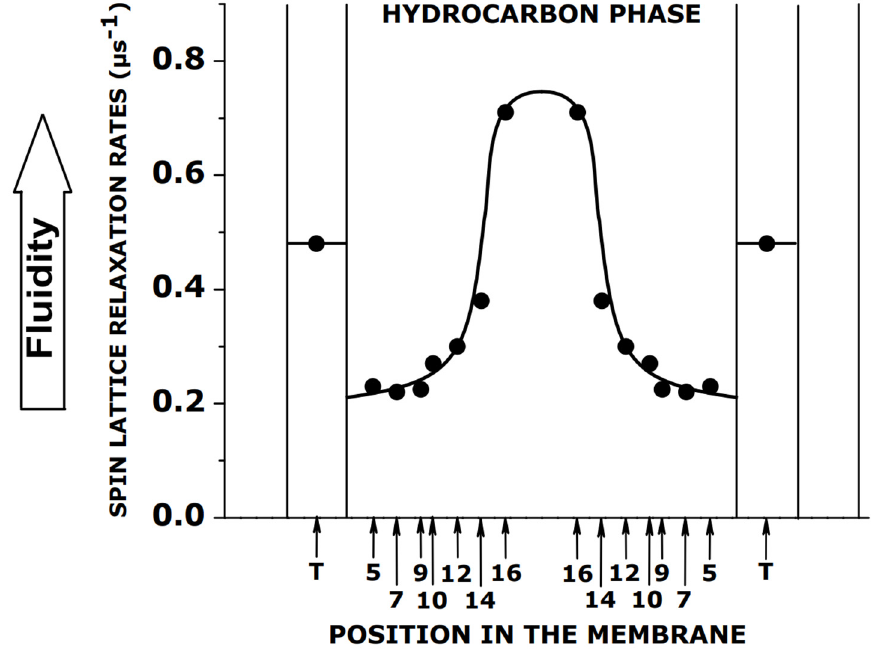
Figure 5. Profile of spin lattice relaxation rates ( T 1 − 1 s) across membranes of multilamellar liposomes made of the lipid extracts pulled from cortical eye lenses of 61–70-year-old human donors. Meas- urements were performed at 37 °C for deoxygenated samples. Locations of spin labels for n-PCs are indicated by numbers and for T-PC by “T”. Based on the data obtained from the neutron diffraction studies on phosphatidylcholine model membranes [64,65] it is assumed that the location of the acyl chain carbon atom in the membrane changes linearly with the position on the acyl chain (the maxi- mal error is about +/ − 1.5 Å). We also assumed that nitroxide moieties in n-PC are located at the same depth as appropriate carbon atoms of the 2-chain of PC membranes [66]. It can also be concluded that a nitroxide moiety stays at the position determined by neutron diffraction for most of the time. Adapted from [60], with permission of the Taylor and Francis Group. As indicated above, and as illustrated in Figures 4b and 5, the T 1 − 1 profiles provide excellent qualitative descriptions of the changes in membrane fluidity that occur after the additions of membrane modifiers. The results recently obtained in the Subczynski lab (not published) show a linear relationship between T 1 − 1 and the rotational diffusion coefficients for the n-PC spin labels in the fluid-phase DMPC/Chol membranes of the multilamellar liposomes. The linearity is independent through the wide range of conditions, including the lipid environment, depth of membrane, local hydrophobicity, and anisotropy of rota- tional motion (independent of the order parameter). Thus, this linear dependence can be used as a calibration curve, allowing transformation qualitative profiles of T 1 − 1 into quan- titative profiles of spin-label rotational rates, which form a description of the membrane fluidity that is precise and easy to understand. Interestingly, a similar linear dependence between spin–lattice relaxation rates and rates of rotational motion was observed for a very different system, namely for various spin-labeled sites in the T4L protein (see Figure 2c in [67]). 5. Oxygen Transport Parameter as a Convenient Monitor of Membrane Fluidity As shown in Section 4, the profiles of T 1 − 1 can qualitatively describe membrane fluid- ity. As a result, the depth-dependent dynamics of the lipids forming the membrane can be acquired from the SR EPR measurements. All of these profiles are smooth and bell- shaped, which is the result of the cumulative effects of rotations that take place simulta- neously at different positions along the chain. The movement of small molecules, such as O 2 , within the membrane is not affected by this cumulative effect. The molecular oxygen, a small and rather hydrophobic probe molecule, enters the vacant pockets transiently